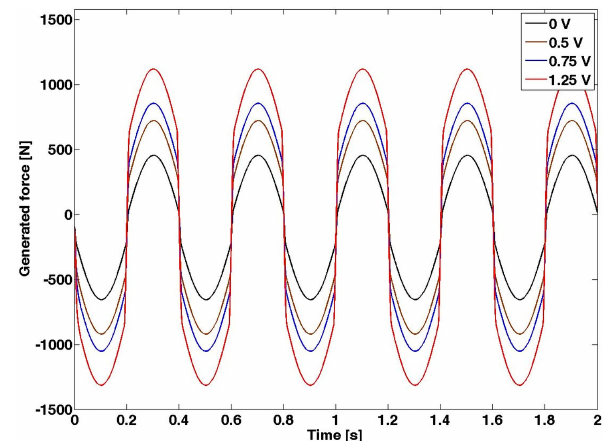
Figure 3. Generated force of the simulated Bouc–Wen model under sinusoidal excitation.